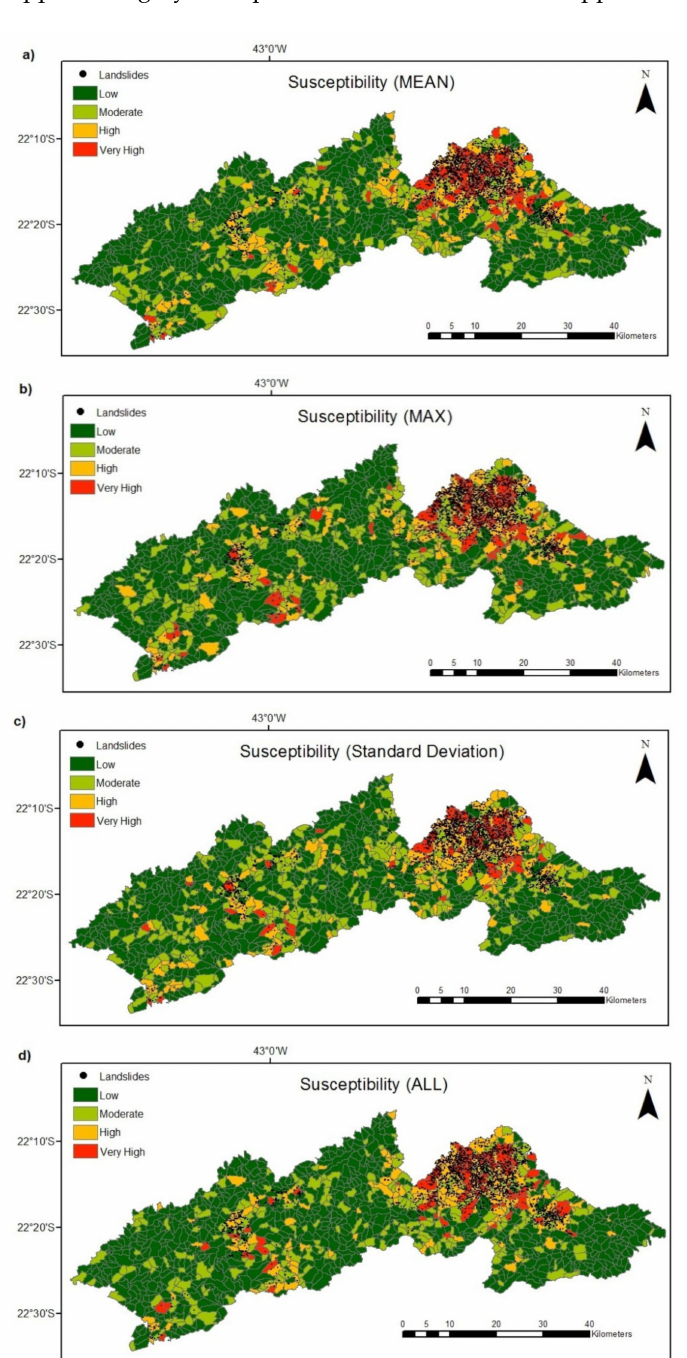
Figure 6. Susceptibility maps generated with the four di ff erent model configurations: ( a ) mean, ( b ) maximum, ( c ) standard deviation and ( d )